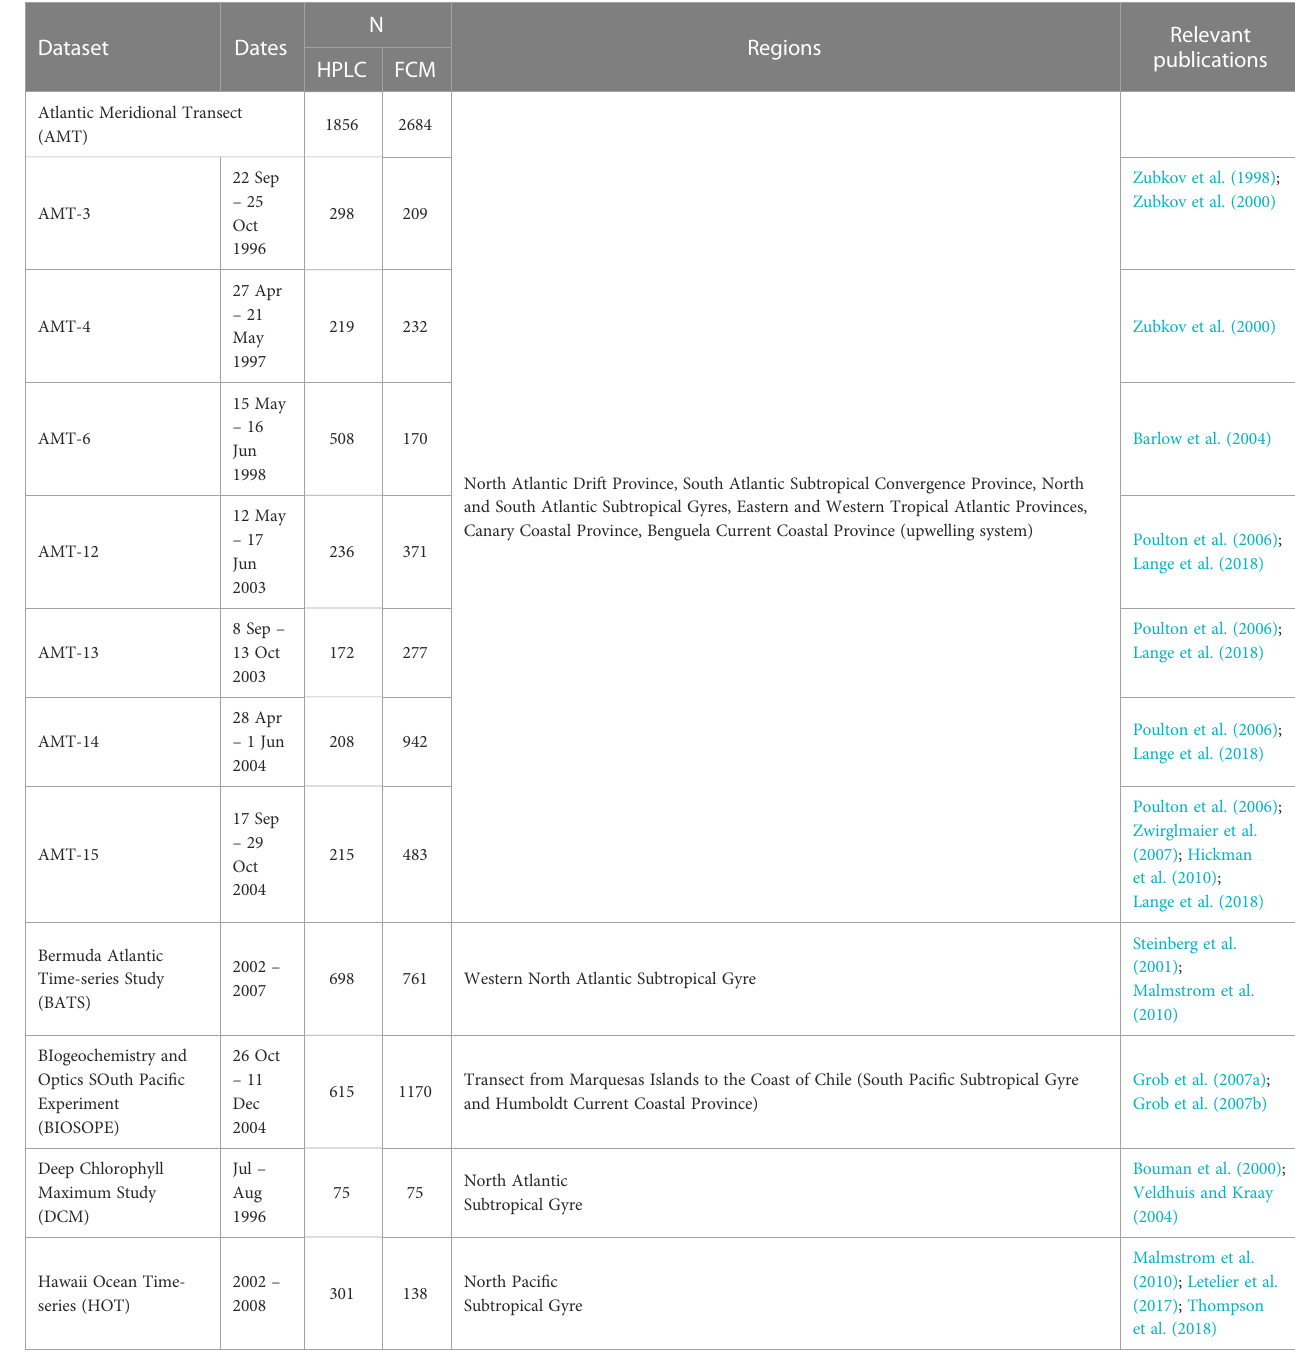
TABLE 1 Summary of oceanographic campaigns included in the